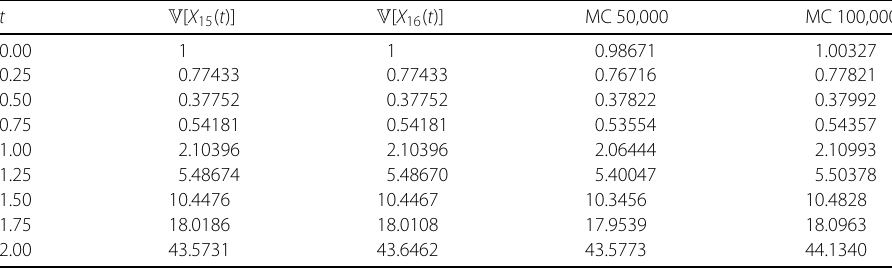
Table 8 Approximation of the variance of the solution stochastic process. Example 4.2